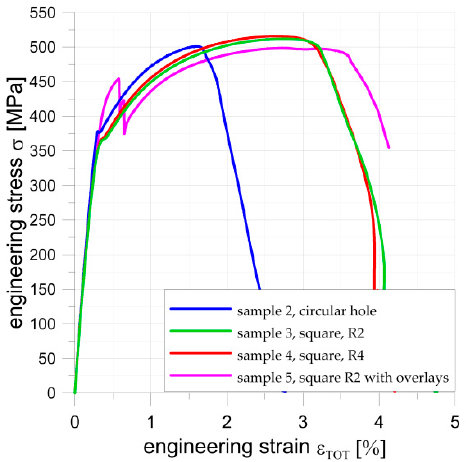
Figure 32. Comparison of engineering stress–strain curve for samples 2–4 with different cut-outs and sample 5 with a square hole with composite overlays.